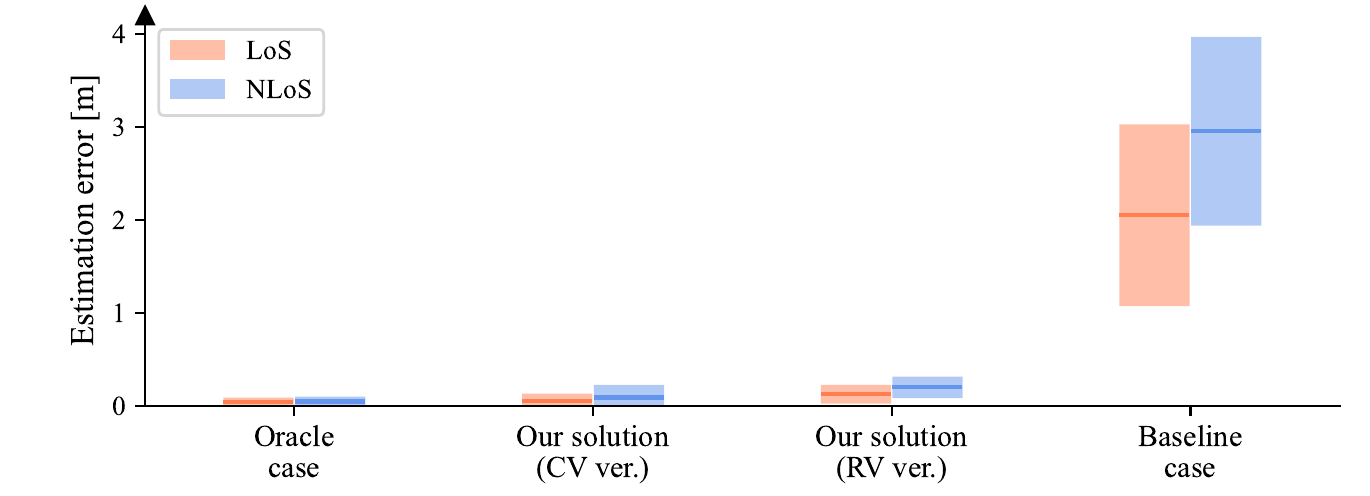
Figure 16. The location-estimation errors of both LoS and NLoS areas for the oracle/baseline cases, and the CV/RV versions of our solution when set e , for each bar, the middle line is mean ( e ) , i.e., MSE, and its height ranges from MSE - std ( e ) to MSE + std ( e )